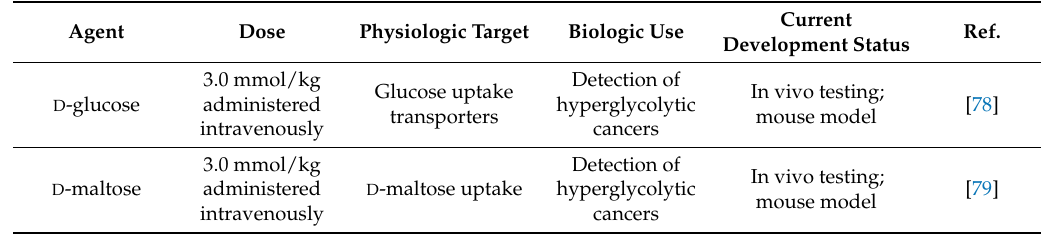
Figure 8. ( A ) Haworth projection of D -glucose. ( B ) Transverse relaxation data from a dynamic in vivo glucose infusion experiment on a mouse. T 2 -weighted images of mouse kidneys from the time of a glucose bolus infusion are displayed (time indicated below each image). ( a ) Effects in all regions displayed. ( b ) Only kidney signal displayed in color on grayscale image to highlight effects. Adapted with permission from [78]. Table 2. Selected T 2ex contrast agents, dosages, biologic use, and current development level. Several agents have made the successful transition to in vivo imaging.